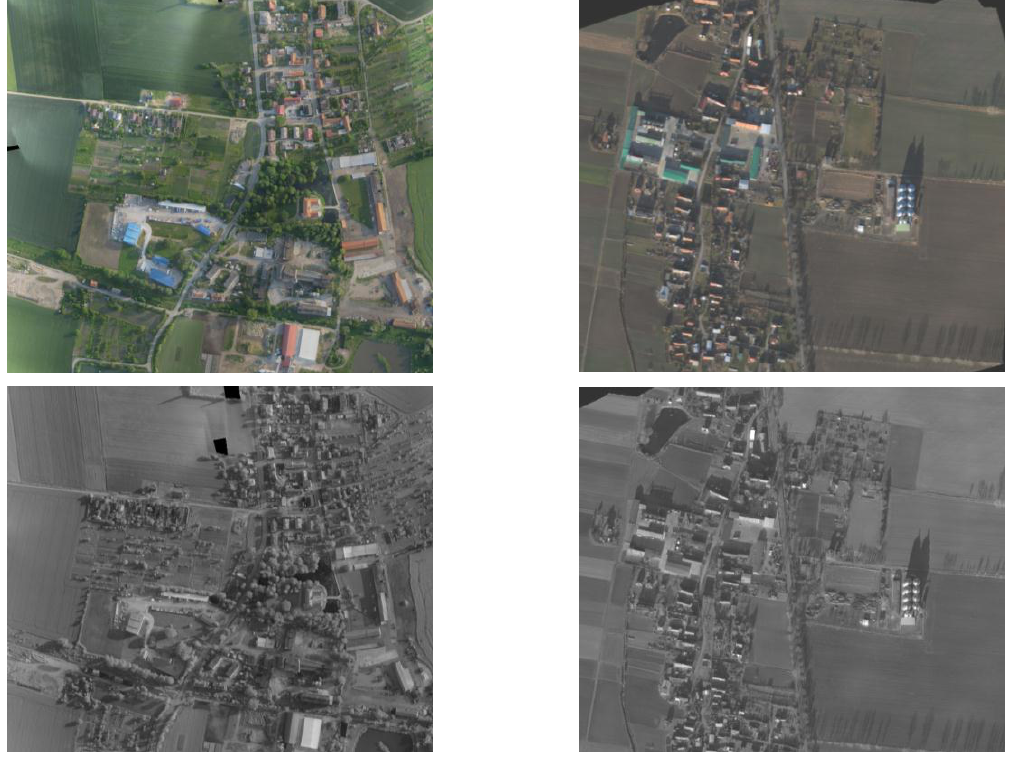
Figure 6: Ortho images for the visible (top) and the NIR spectrum (bottom) that have been obtained by combining both datasets into a single reconstruction. Images obtained by Pteryx UAV, courtesy of Trigger Composites.